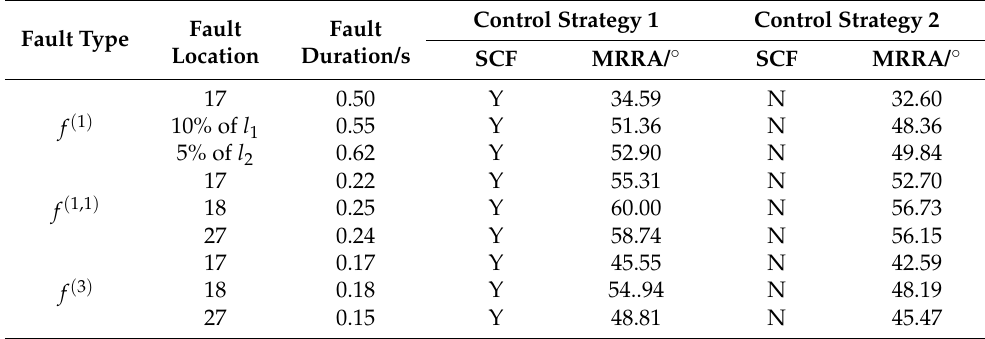
Table 3. Comparison of simulation results by different control strategies in the full electromag- netic